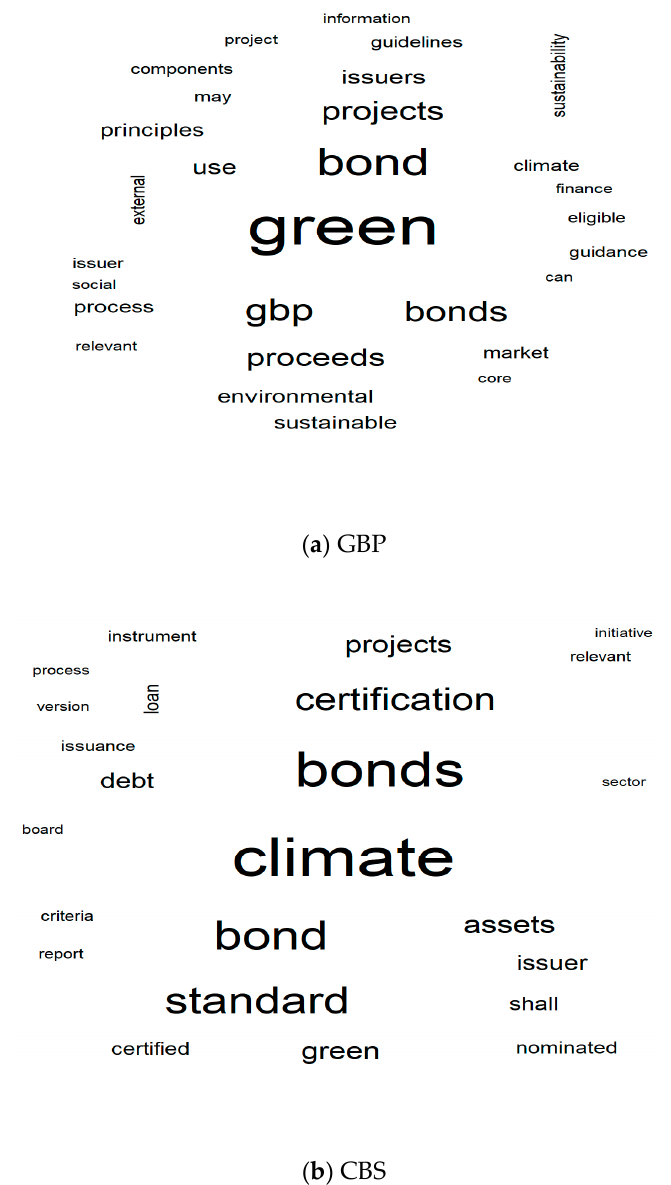
Figure 4. Word cloud result for the international GB guidelines .